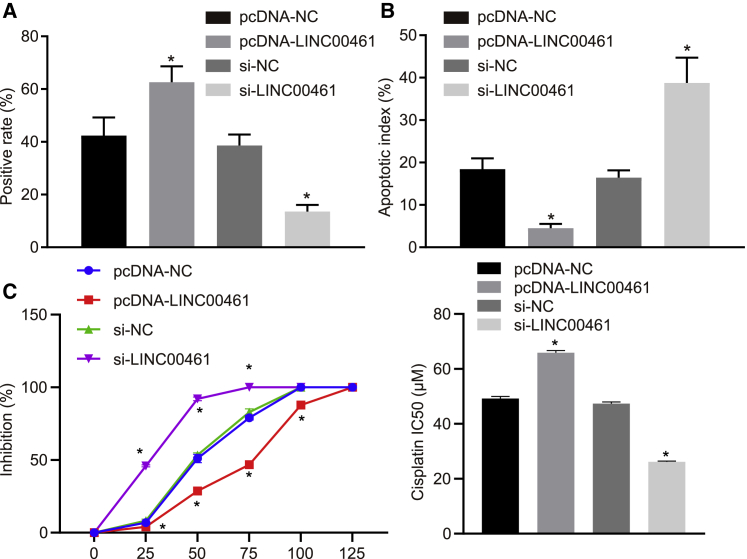
Silencing of LINC00461 inhibits chemoresistance of HNSCC to cisplatin(A) The proliferation of HNSCC cell line FADU/DDP. Red fluorescence represents proliferated cells and blue fluorescence represents nuclei. (B) The apoptosis rate of HNSCC cell line FADU/DDP. (C) The resistance to cisplatin in HNSCC cell line FADU/DDP. All of the data were measurement data expressed as means ± standard deviations. The data among multiple groups were compared using 1-way ANOVA. The experiment was conducted 3 times independently. ∗p < 0.05 versus the pcDNA-NC group or the si-NC group.